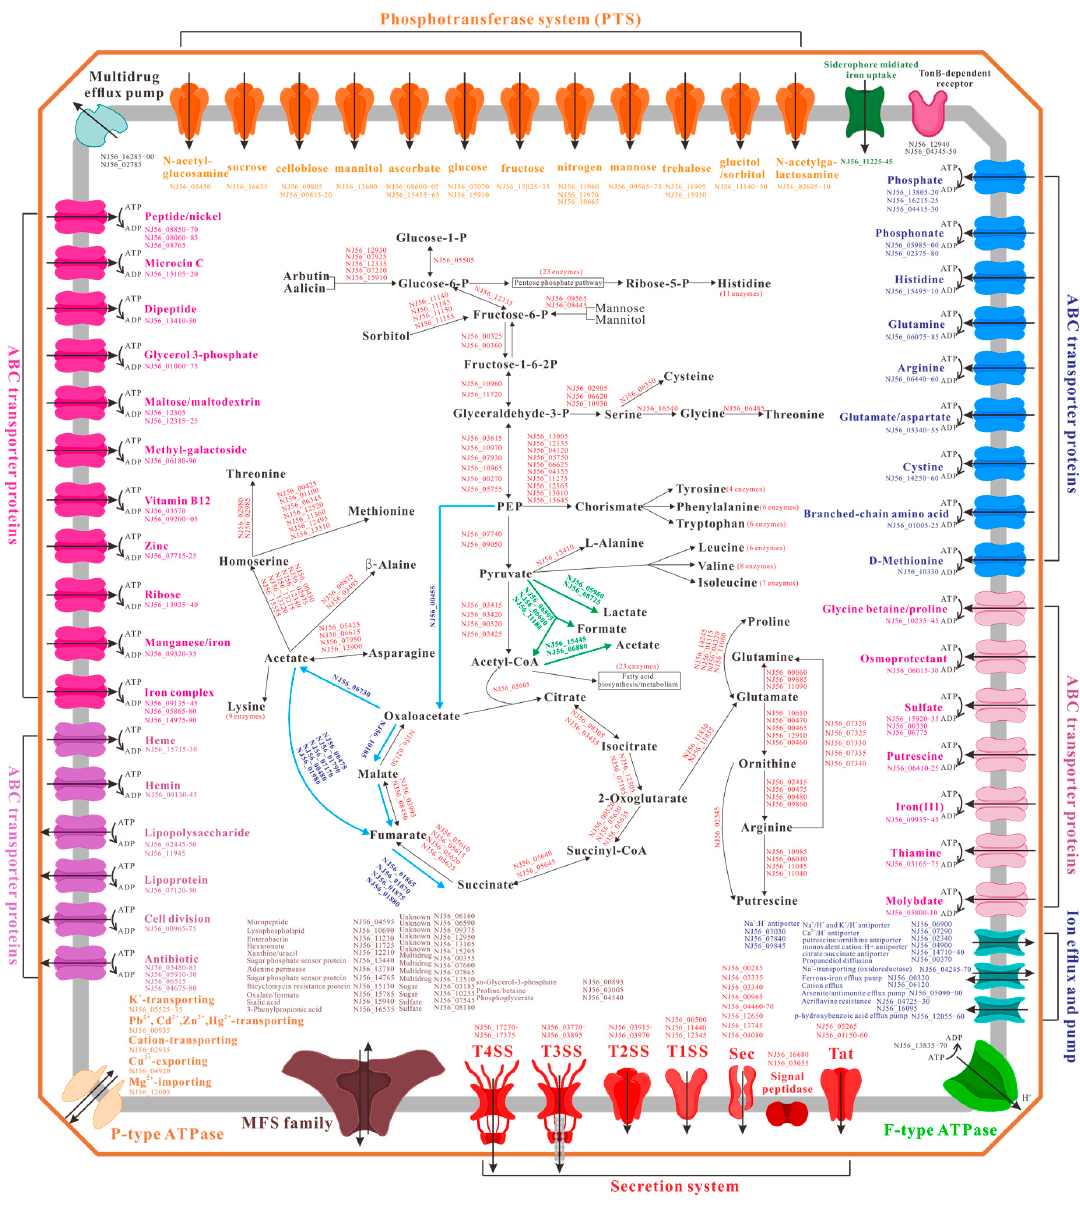
Figure 8. Overview of metabolism and transport in SC09. Different transport families are distinguished by different colors and shapes.